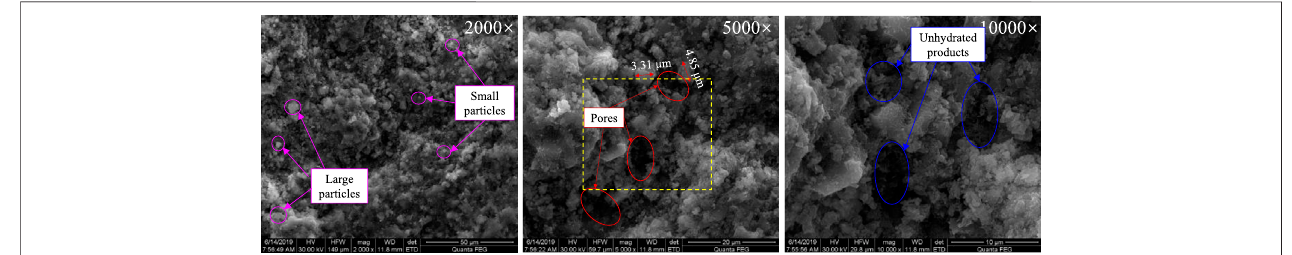
FIGURE 3 | SEM results: ordinary saturated concrete